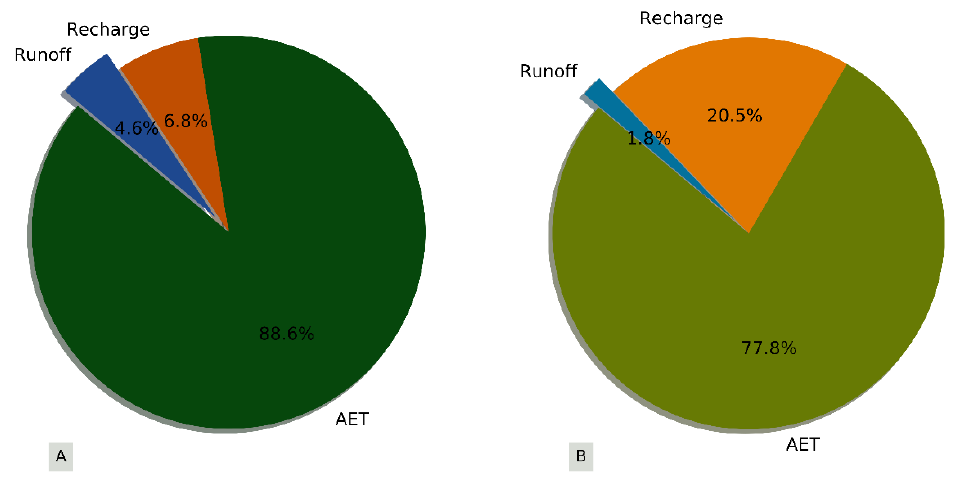
Figure 12. Water balance model type, water budget comparison from 2071-2100. ( A ) The monthly water budget calculation likely overestimates AET because of monthly calculation of precipitation (P) less PET (P − PET). ( B ) The continuous simulation, distributed parameter model calculates daily P − PET which produces less AET and more water availability for the month because a daily comparison can have multiple days within a month where P > PET even if PET > P for the month.